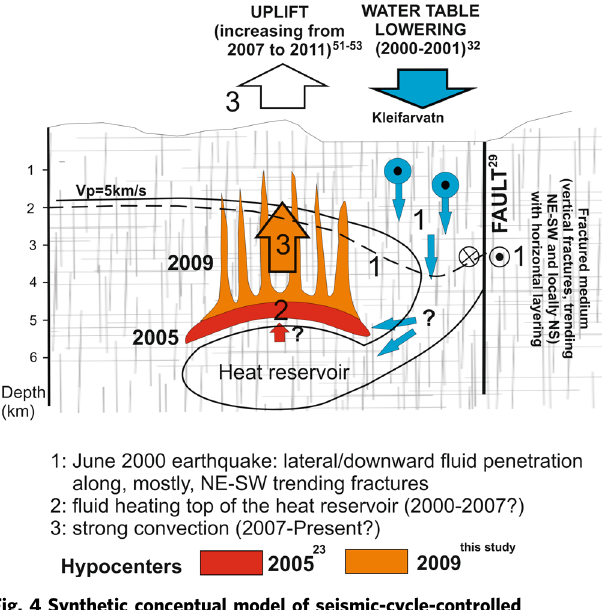
Fig. 4 Synthetic conceptual model of seismic-cycle-controlled hydrothermal fl uid convection in the Krýsuvík – Kleifarvatn geothermal area. Dashed line: possible boundary between upper fl uid reservoir with hydrostatic pressures and deeper over-pressurized (quasi-lithostatic?) fl uid reservoir. Further explanations in the